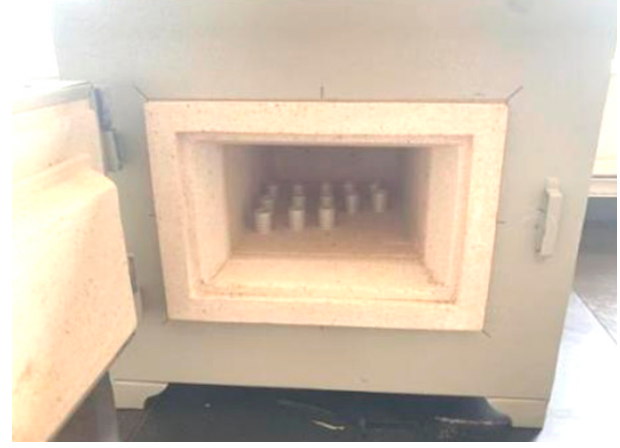
Figure 5. Heat-cured silver electrodes.